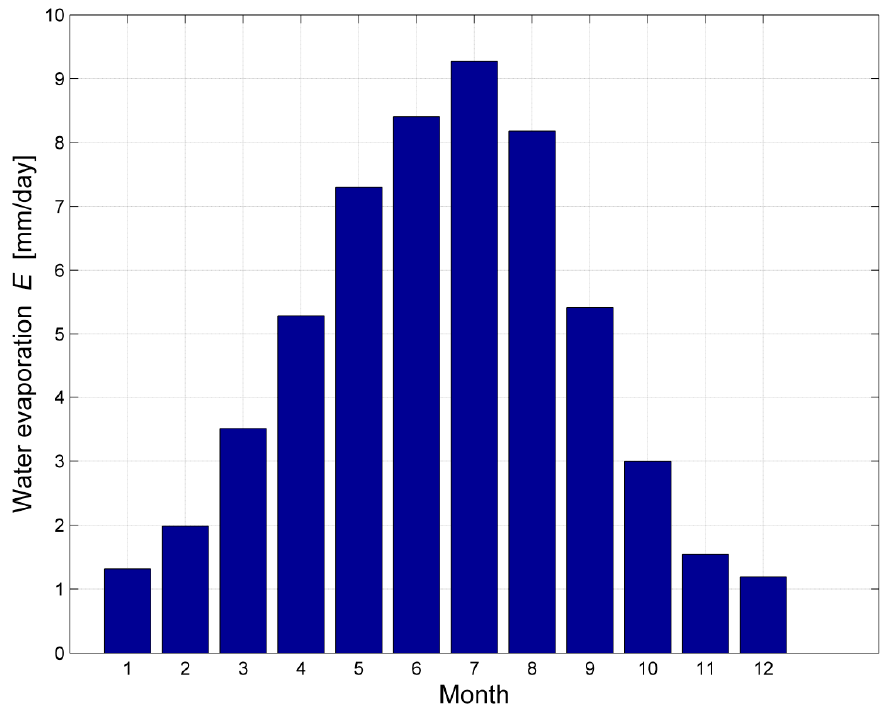
Figure 14. Reduction of the depth of Skadar Lake due to water evaporation for an average day in each month.